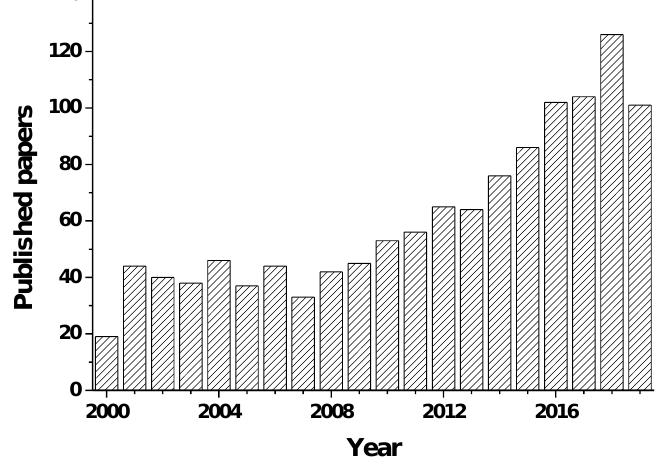
Figure 5. Statistical graph of papers using enzymes as catalyst in CO 2 conversion published during the past two decades.